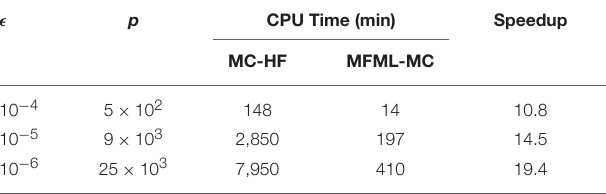
TABLE 2 | Performance chart of MFML-MC estimator for test case 2.